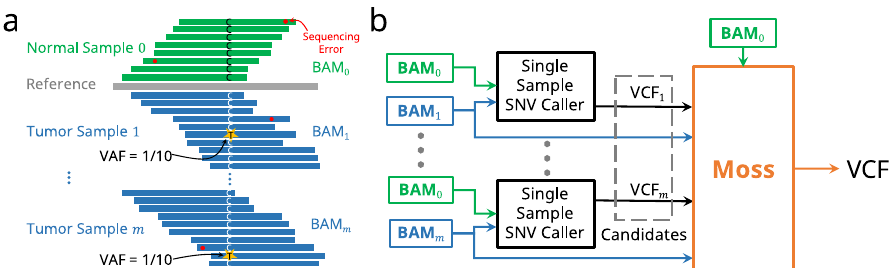
Fig. 1 Moss extends current single-nucleotide variant callers by leveraging multiple samples to improve recall. a When multiple tumor samples are analyzed simultaneously, single-nucleotide variants (SNVs, yellow stars) with low variant allele frequency (VAF) can be more easily distinguished from sequencing errors (red dots) than when tumor samples are analyzed in isolation. b Work fl ow overview of Moss, taking as input BAM (or SAM) fi les of a matched normal sample (subscript 0) and m tumor samples, along with m VCF (variant call format) fi les obtained by any existing single-sample SNV caller. The output of Moss is an aggregate VCF fi le containing the called SNVs present in the m tumor